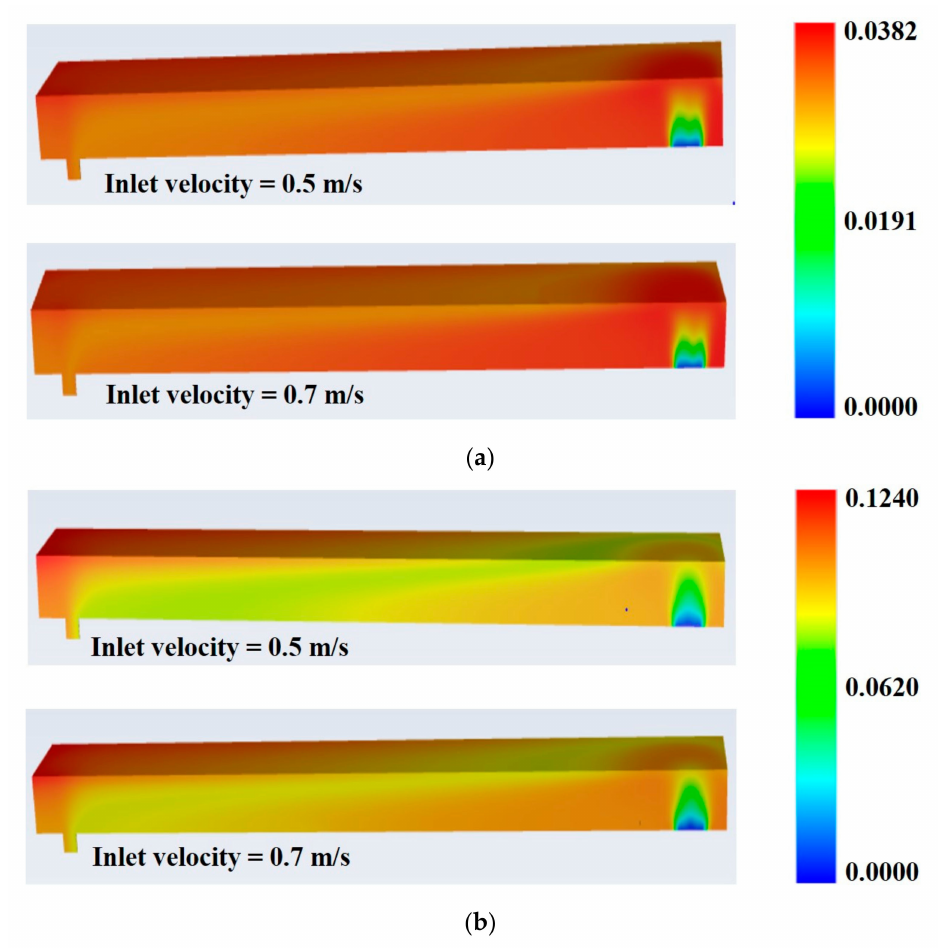
Figure 7. Contours of H 2 O mass fraction: ( a ) case I; and ( b ) case II at di ff erent inlet